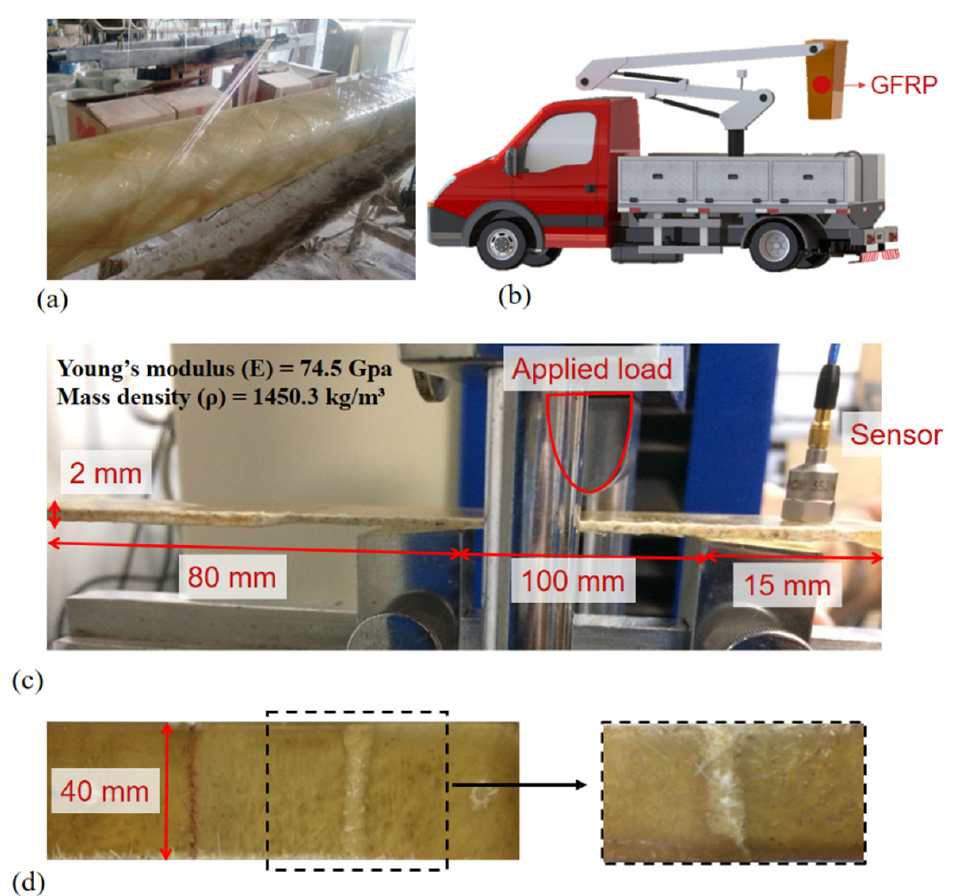
Figure 6. ( a ) Specimen manufacturing; ( b ) GFRP application example; ( c ) The sample dimensions and test conditions; ( d ) The ruptured specimen final configuration with a detailed view of the frac- ture.